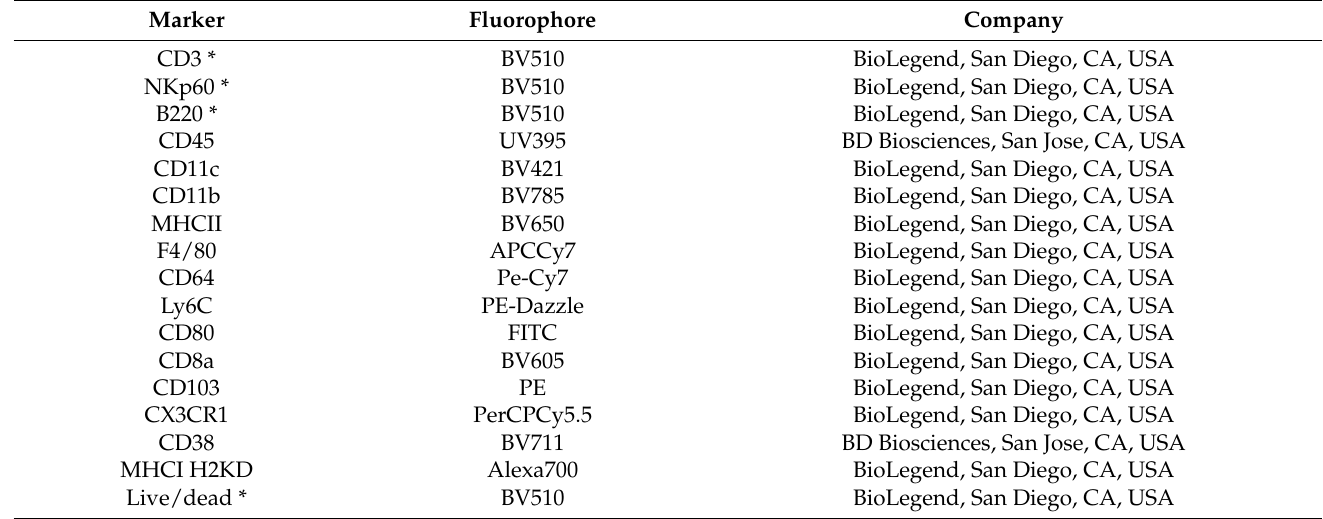
Table 2. List of the anti-mouse conjugated antibodies for the analysis of dendritic cells via FACS.